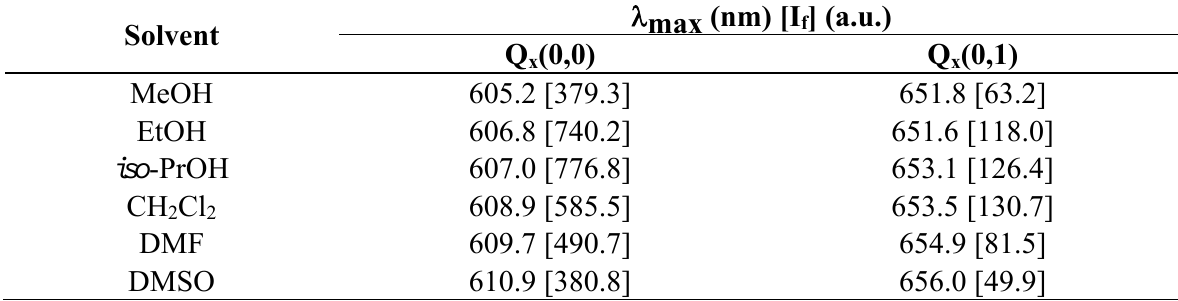
(c = 2.5 × 10 − 6 M, λ p